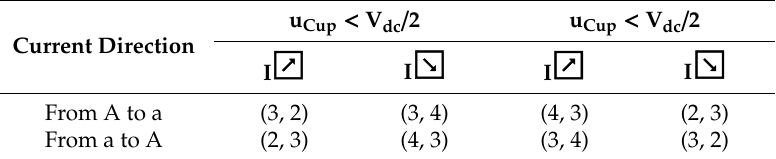
Table 3. Switching Status for Mid-point Voltage Balance Control (Sa, Sa).